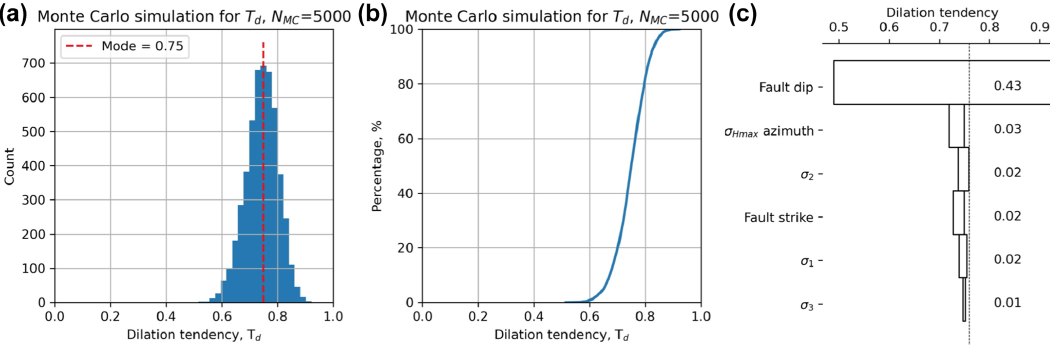
Figure A3. Output from Monte Carlo simulation ( N MC = 5000) of dilation tendency calculated using a quadratic response surface from synthetic input data. (a) Histogram of calculated dilation tendency values, in this case showing a quasi-normal distribution with a mode of ∼ 0.75. (b) Cumulative distribution function (CDF) of calculated dilation tendency values, showing the range in values from ∼ 0.5 to ∼